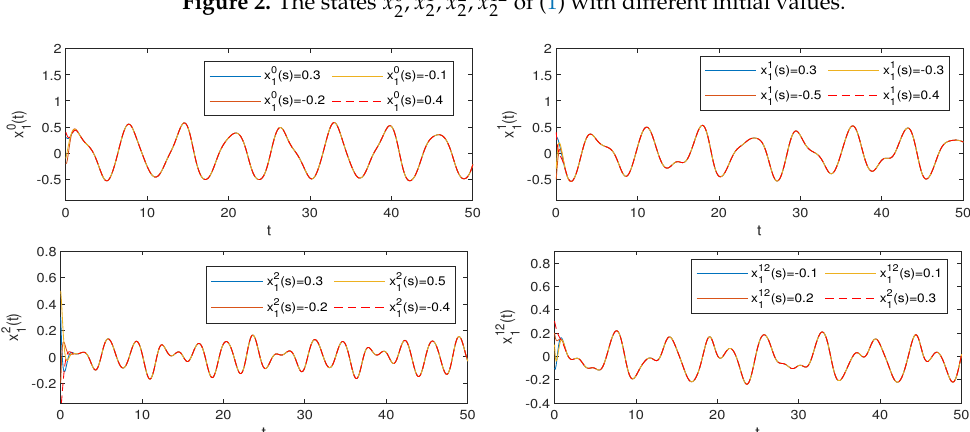
Figure 2. The states x 0